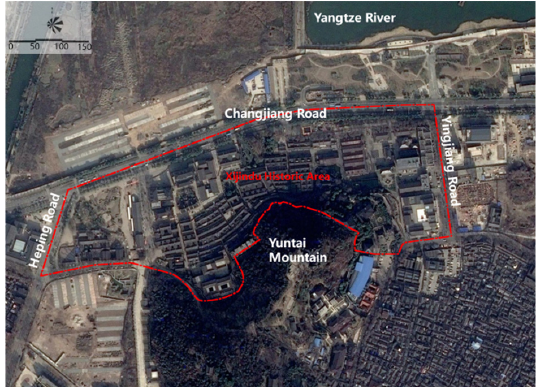
Figure 6. The boundary of Xijindu historical area.